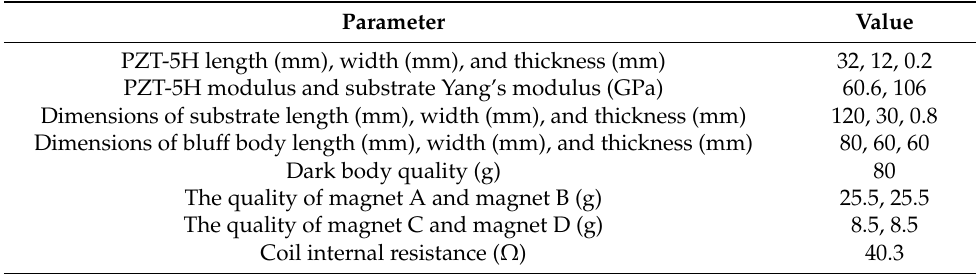
Table 1. Structural and material parameters of the MPEGEH.